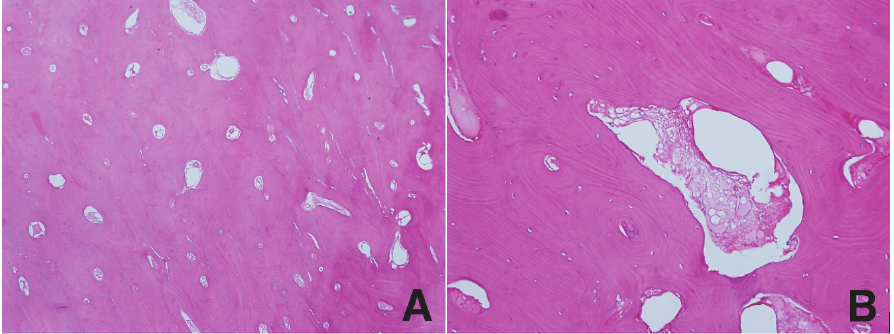
Figure 4 : Clavicular parosteal osteoma histopathological imaging (a) dense compact sclerotic bone with prominent haversian system (HE × 100). (b) Irregular haversian system is noticed due to focal resorptive activity (HE ×